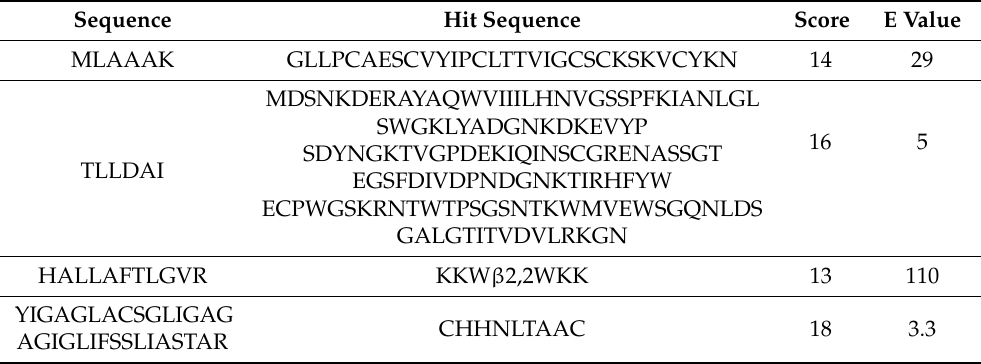
Table 2. Results of the blast of mACPpred to predict anticancer peptides in the CancerPPD database. Sequence Hit